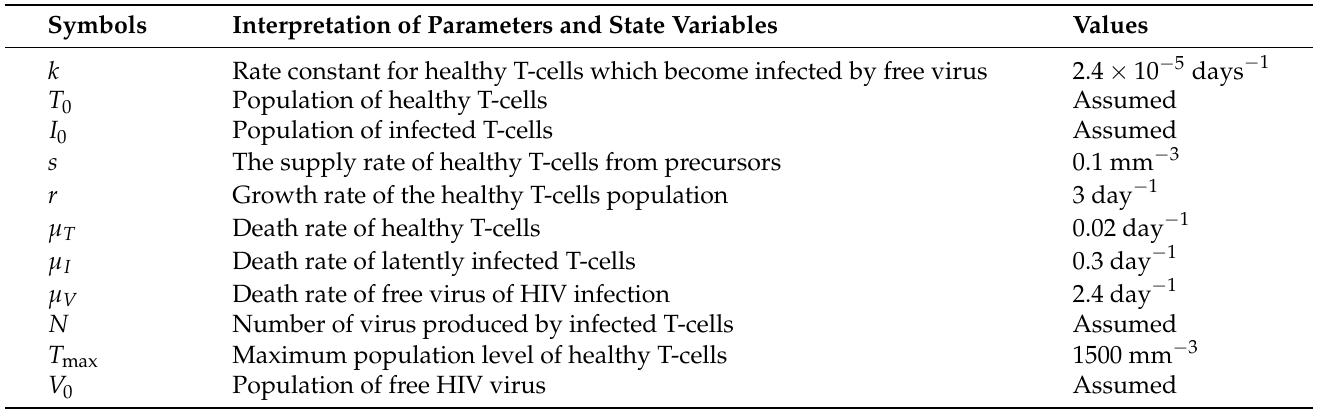
Table 1. List of parameters and state variables with corresponding values used in the fractional model of HIV infection. Symbols Interpretation of Parameters and State Variables Values k Rate constant for healthy T-cells which become infected by free